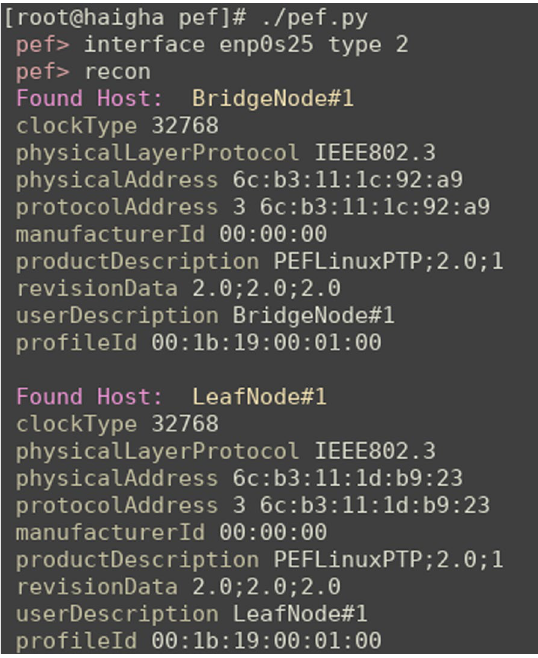
Fig. 4 PTP Exploitation Framework demonstration; the reconnaissance module displays the information got from the running PTP